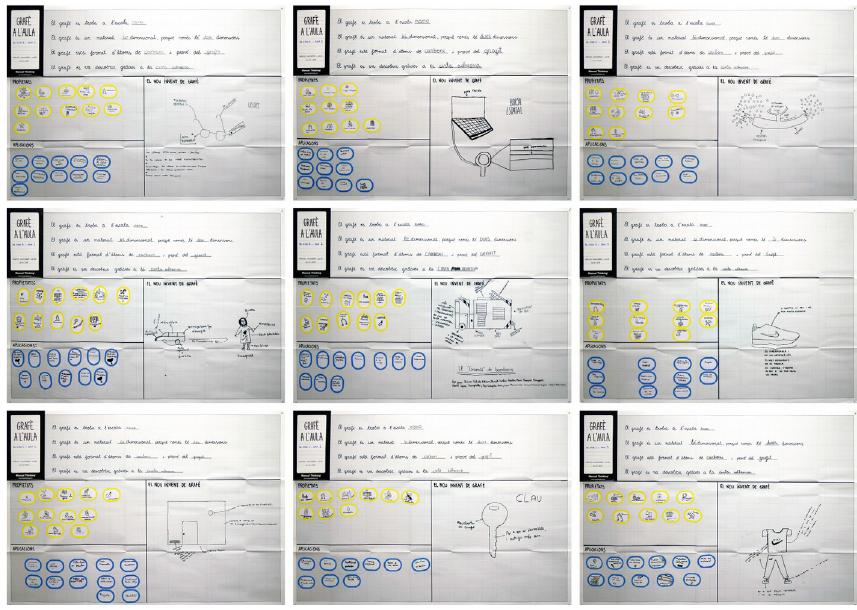
Figure 3. Maps filled out by